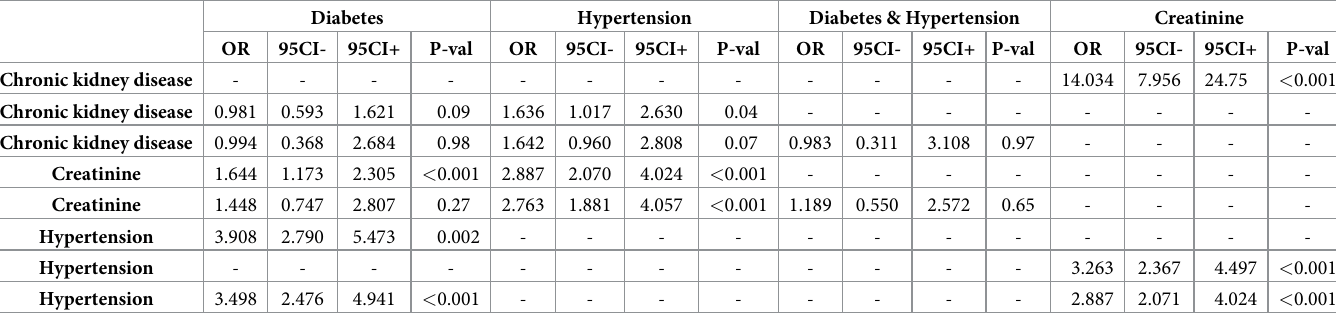
Table 10. Interaction of the different risk factors of COVID-19 probed against